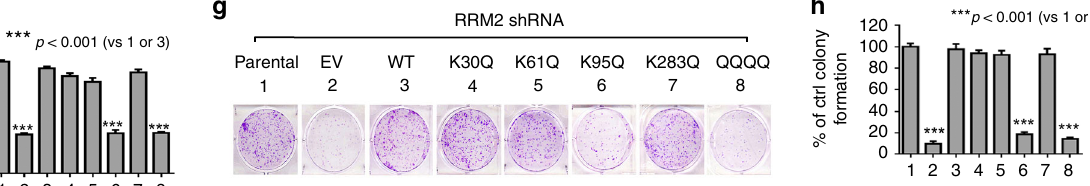
Fig. 8 RRM2 acetylation at K95 results in reduction of dNTP pool size and growth inhibition. a After endogenous RRM2 was depleted from H1299 cells using 3 ′ -UTR-targeted RRM2 shRNA, Flag-tagged WT or individual acetyl-mimetic RRM2 mutant(s) were exogenously expressed in RRM2-de fi cient H1299 cells. b – h Intracellular dNTPs, DNA replication fork progression, cell proliferation, and cell growth were analyzed by HPLC, DNA fi ber assay, BrdU/7-AAD proliferation assay, and colony-formation assay, respectively, in RRM2-de fi cient H1299 cells expressing empty vector (EV), Flag-tagged WT, or individual acetyl-mimetic RRM2 mutant(s). The error bars indicate ± s.d. of three separate experiments. * P <0.05, ** P <0.01, *** P <0.001, by two-tailed t